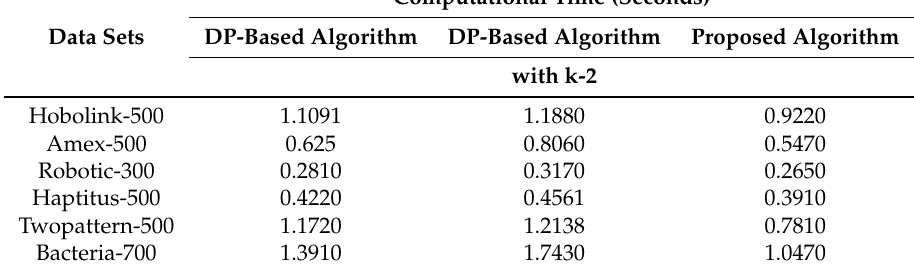
Table 3. Comparison of the computational times (in seconds) of the proposed and dynamic programming-based algorithms—using benchmark data sets (minimum values, as shown in bold face, are better)